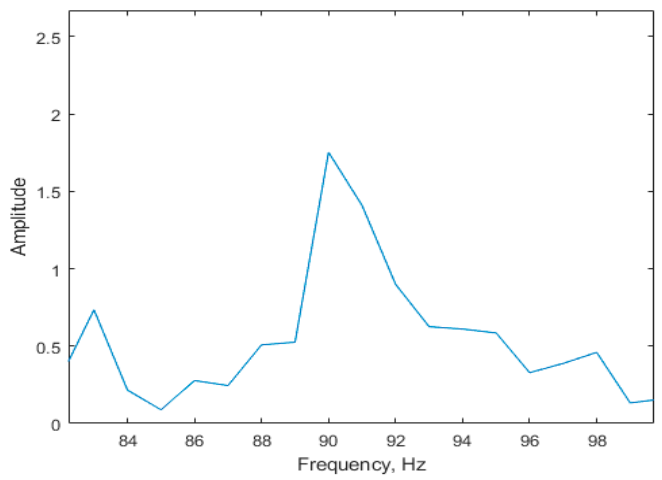
Figure 19. Amplitude spectrum of a faulty asynchronous motor in steady state.